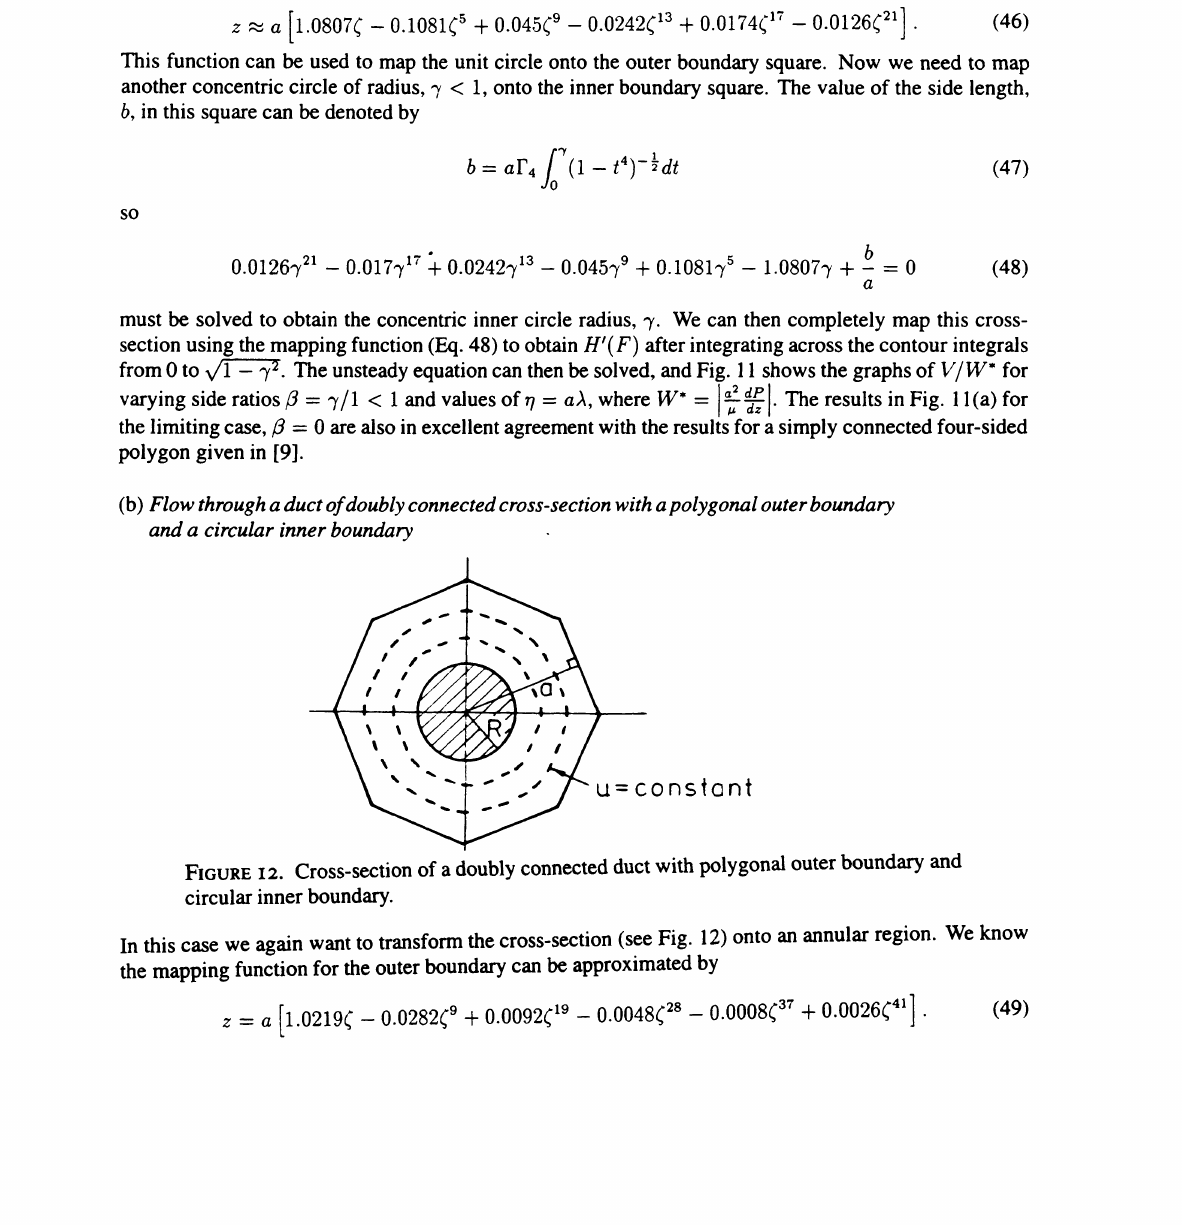
TABLE I. Numerical values for mapping coefficients of regular polygonal